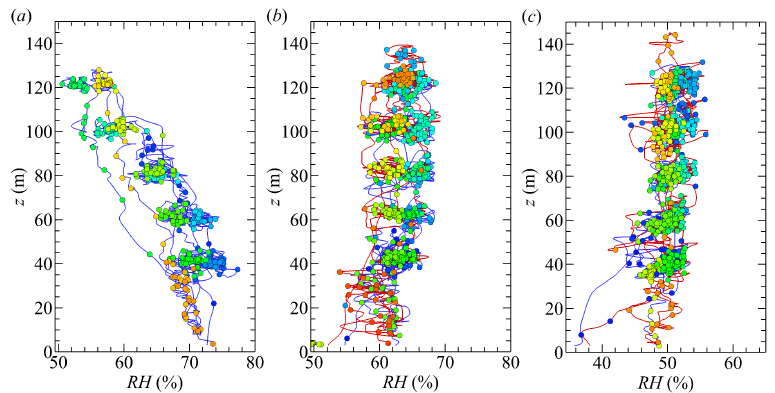
Figure 9. Altitude dependence of relative humidity measured by the two aircraft during ( a ) flight 1, ( b ) flight 2, and ( c ) flight 3. Symbols represent a 5 s separation in time and the color of symbols represents position in time (blue at start of flight transitioning to red with increasing time). Blue lines indicate measurements made by BC5A and red lines indicate measurements made by BC5B.